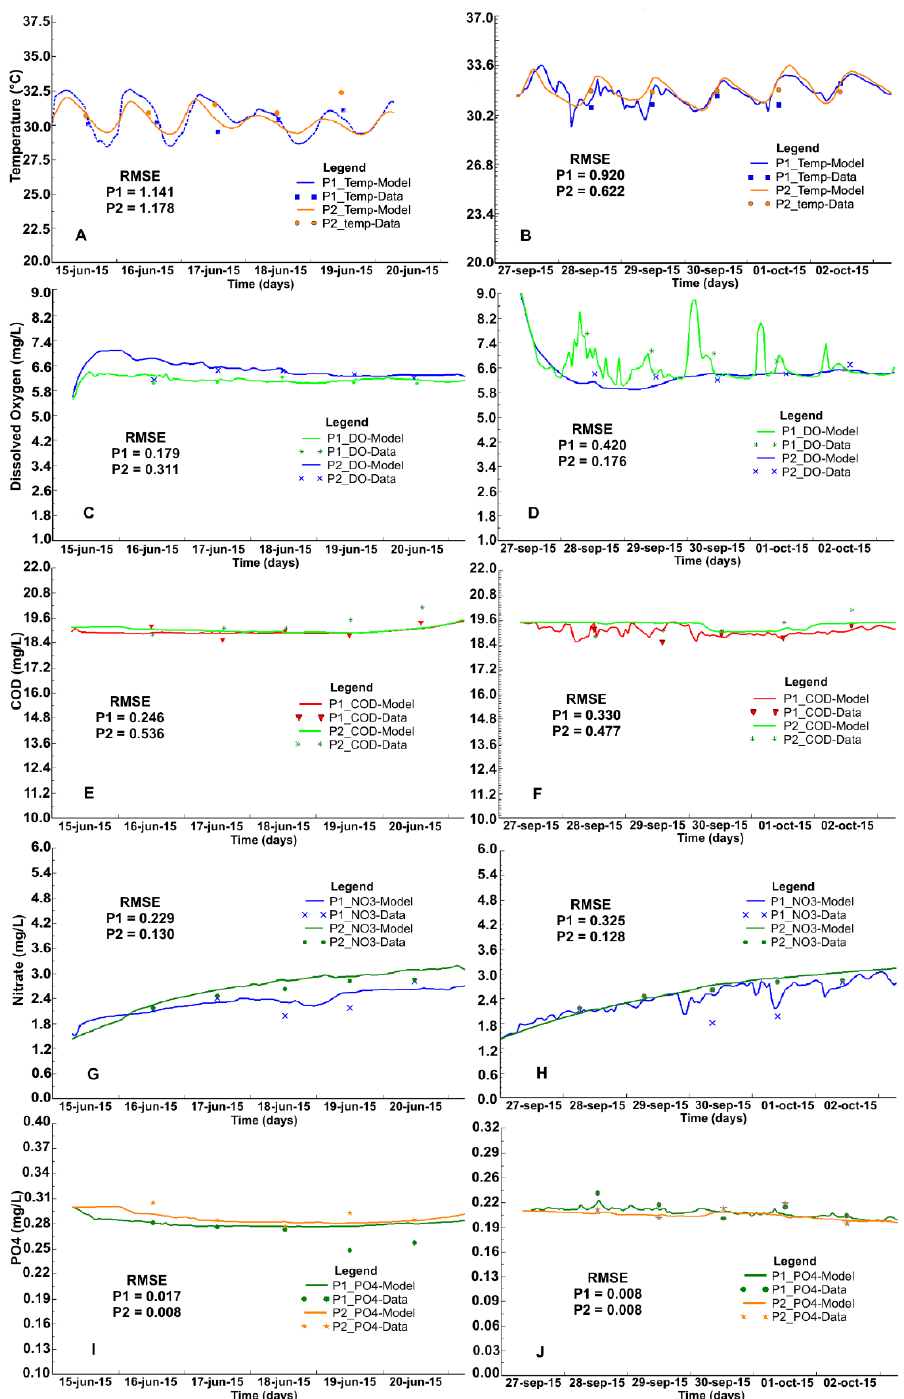
Fig. 3: Hydrodynamic validation and calibration water quality parameters. A) Temperature for the transition period. B) Temperature for the wet season. C) DO for the transition period. D) DO for the wet season. E) COD for the transition period. F) COD for the wet season. G) NO 3 for the transition period. H) NO 3 for the wet season. I) PO 4 for the transition period. J) PO 4 for the wet season